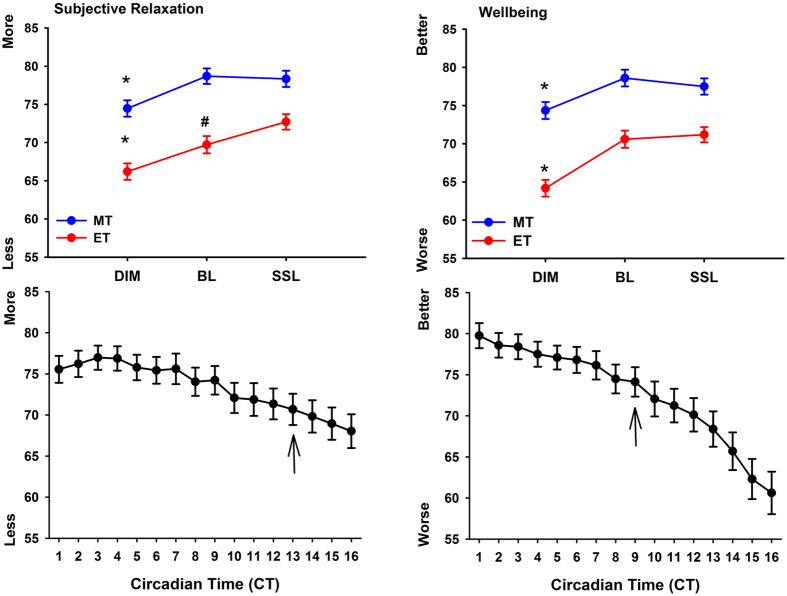
Upper two graphs: averaged values for subjective relaxation (left side) and wellbeing (right side) per light condition (DIM; BL; SSL) for both chronotypes (MT = blue symbols; ET = red symbols; means ± SEM).*Significant differences between DIM - BL and DIM and SSL within each chronotype (p < 0.05); #significant differences between BL and SSL in ET only (p < 0.05; ‘condition’ × ‘chronotype’). The lower two graphs show the time course for subjective relaxation (left side) and wellbeing (right side) across all three lighting conditions (main effect of ‘time’). The black arrows indicate the beginning of the progressive worsening, when compared to CT 1 for both chronotypes (main effect of ‘time’; p < 0.05).